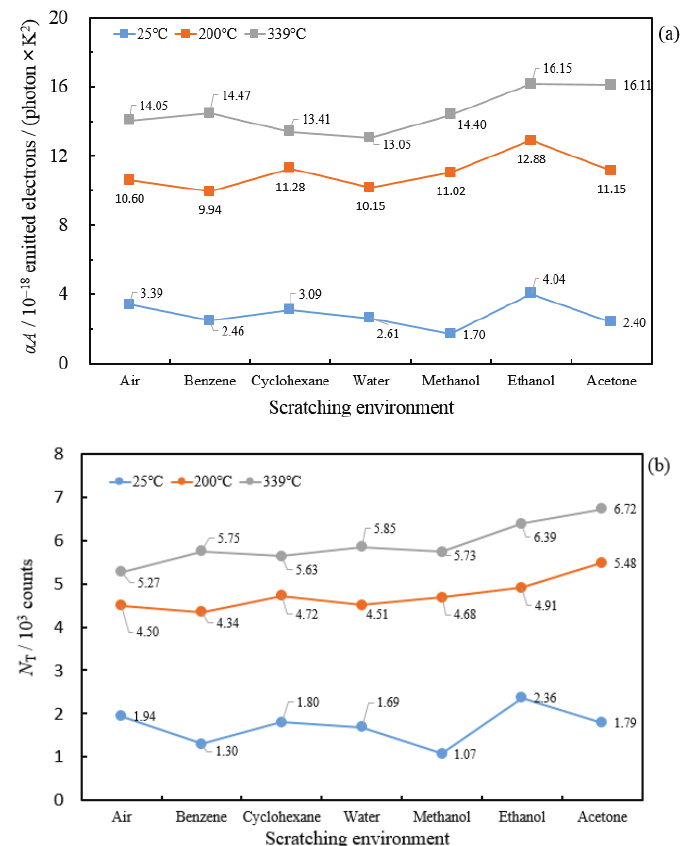
Figure 11. Dependence of the average electron photoemission probability, α A ( a ), and the total number of emitted electrons, N T ( b ), obtained from the PE measurement during the wavelength scan at 25, 200, and 339 ◦ C for real iron surfaces on the scratching environments: (1) air, (2) benzene, (3) cyclohexane, (4) water, (5) methanol, (6) ethanol, and (7) acetone.